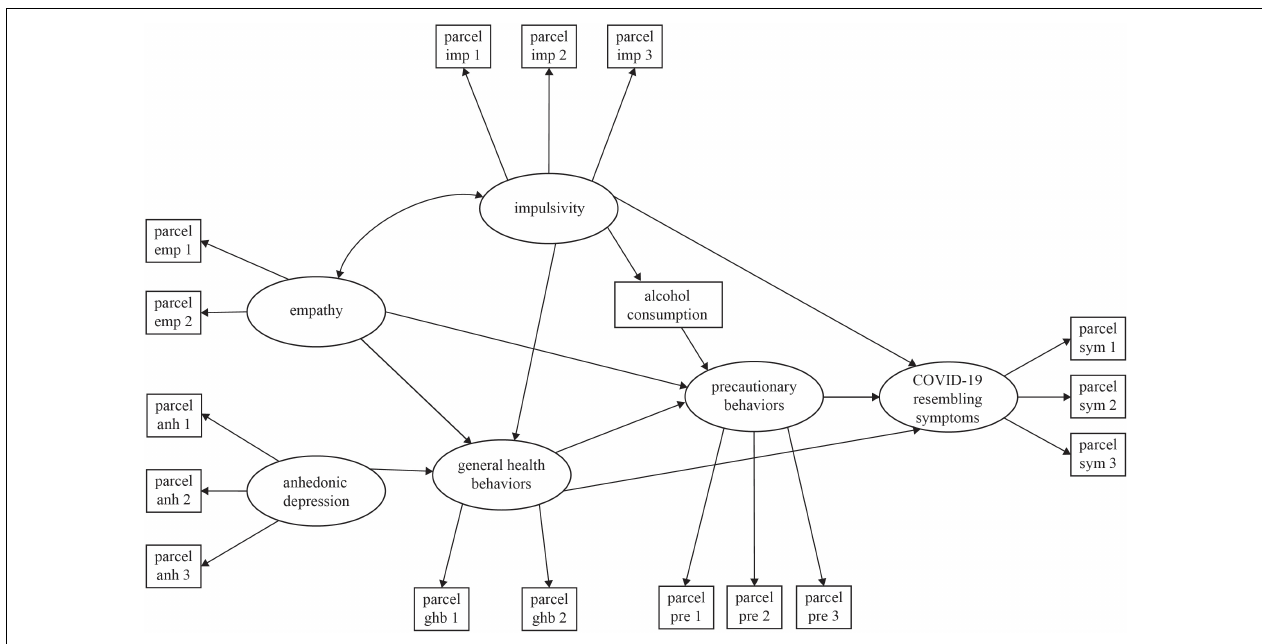
FIGURE 1 | Theoretical model of predictors of precautionary